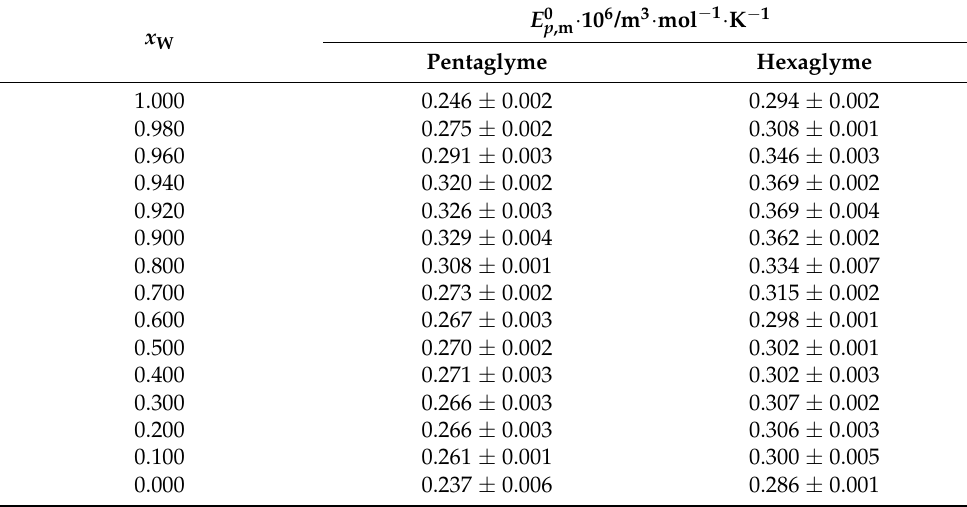
Table 3. Standard isobaric molar thermal expansion of glymes in the DMF + W mixture.